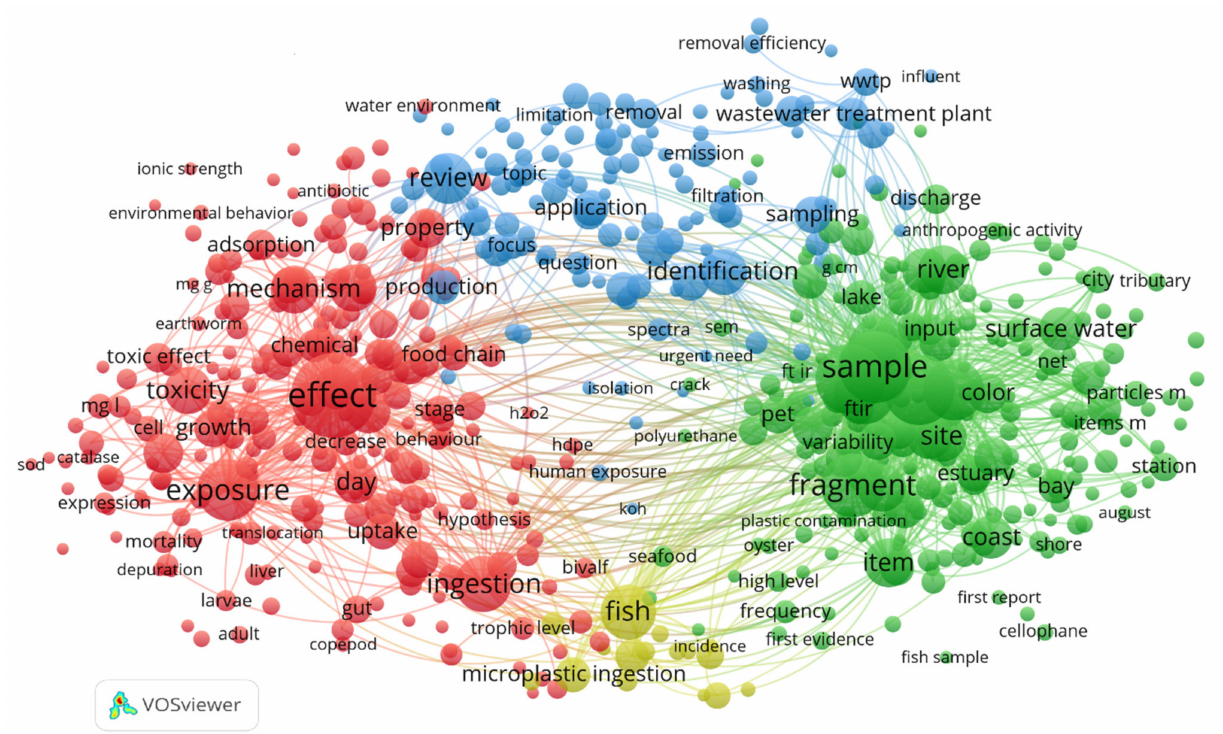
Figure 2. Co-citation analysis of published papers about microplastics around the